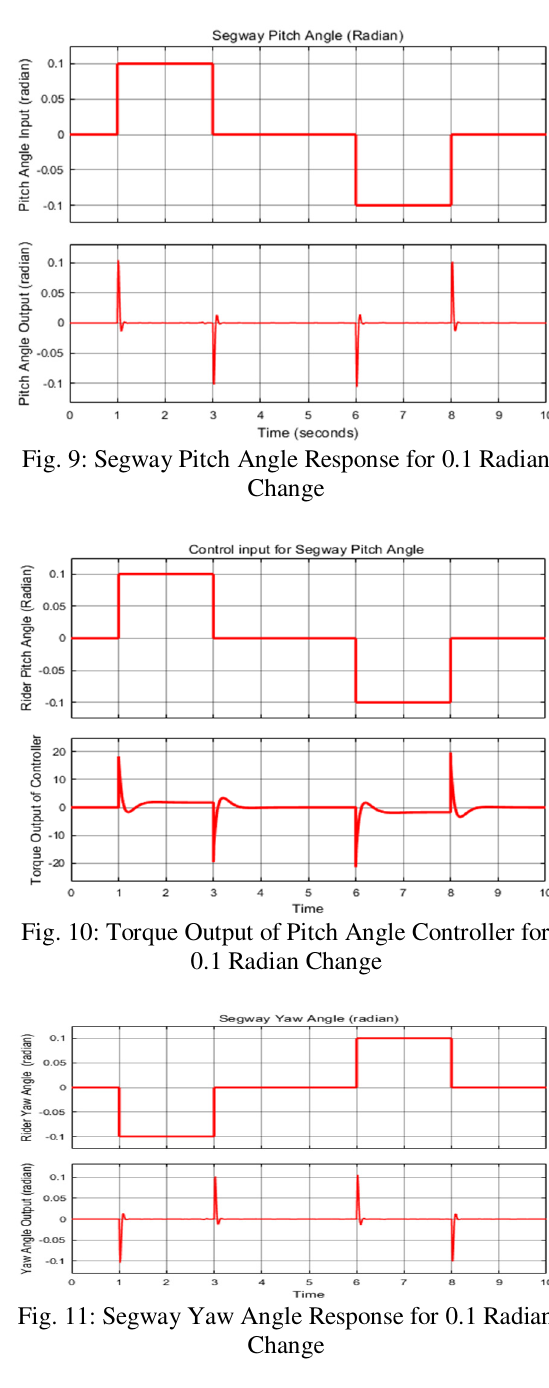
A right and left-turning control system is designed to control the Segway in turning right and left. A change in yaw angle is required to turn Segway left and